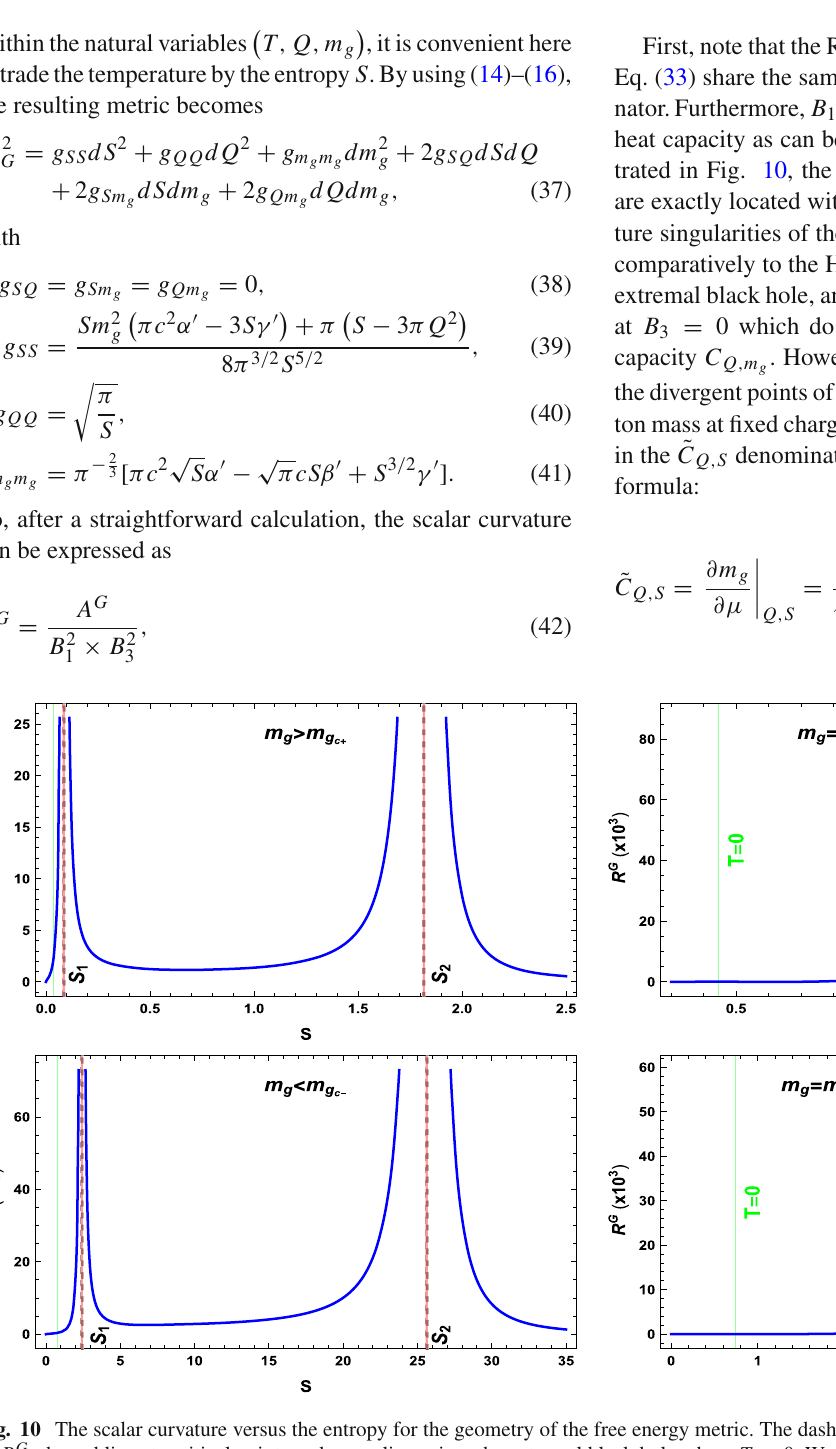
Fig. 10 The scalar curvature versus the entropy for the geometry of the free energy metric. The dashed lines correspond to the divergency points of R G , the red lines to critical points and green lines gives the extremal black hole where T = 0. We used the following values: Q = 0 . 5, α = 1, β = 2 and c =